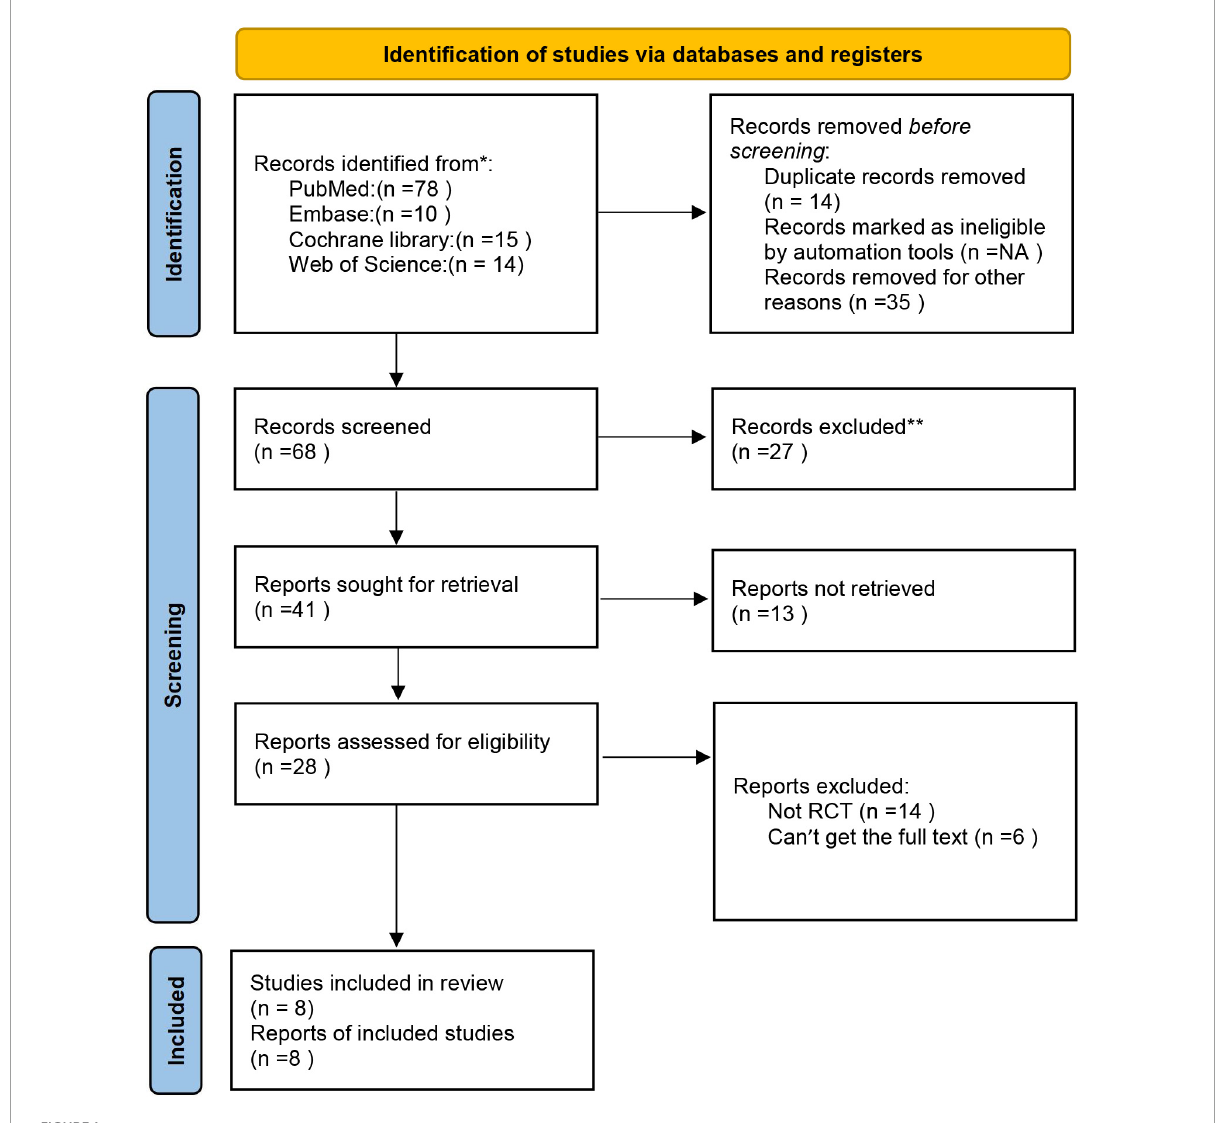
FIGURE1 The flow diagram of the literature research and study selection according to the PRISMA guidelines.